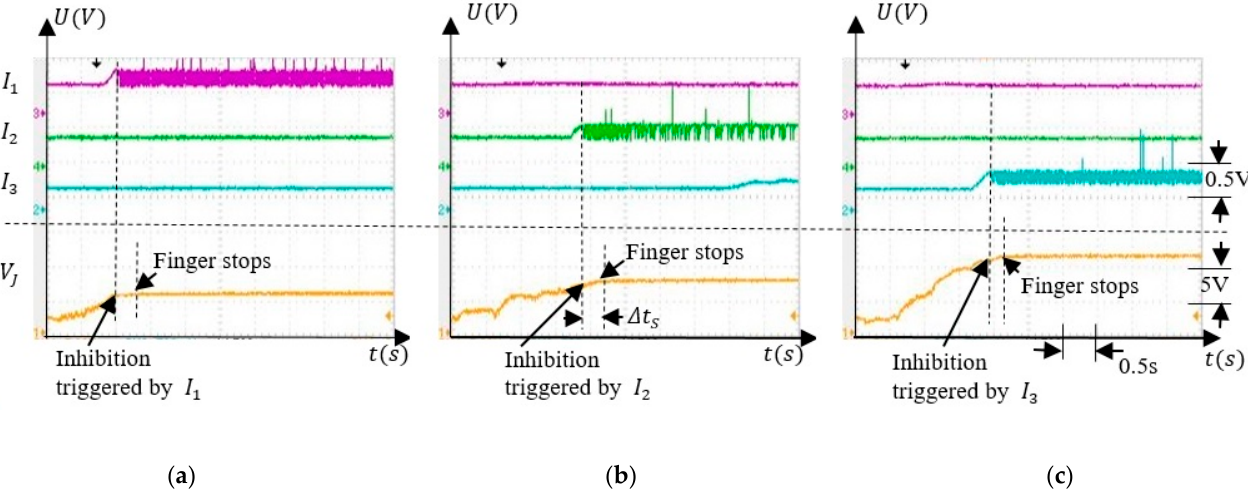
Figure 10. The activity of the critical neurons before training showing the angle interval selection; ( a ) (cid:1831) (cid:2869)(cid:2879)(cid:2871)(cid:3005) when the arti- ficial finger was rotated by the hand; ( b ) (cid:1835) (cid:2869)(cid:2879)(cid:2871) when the SMA actuator rotated the finger.